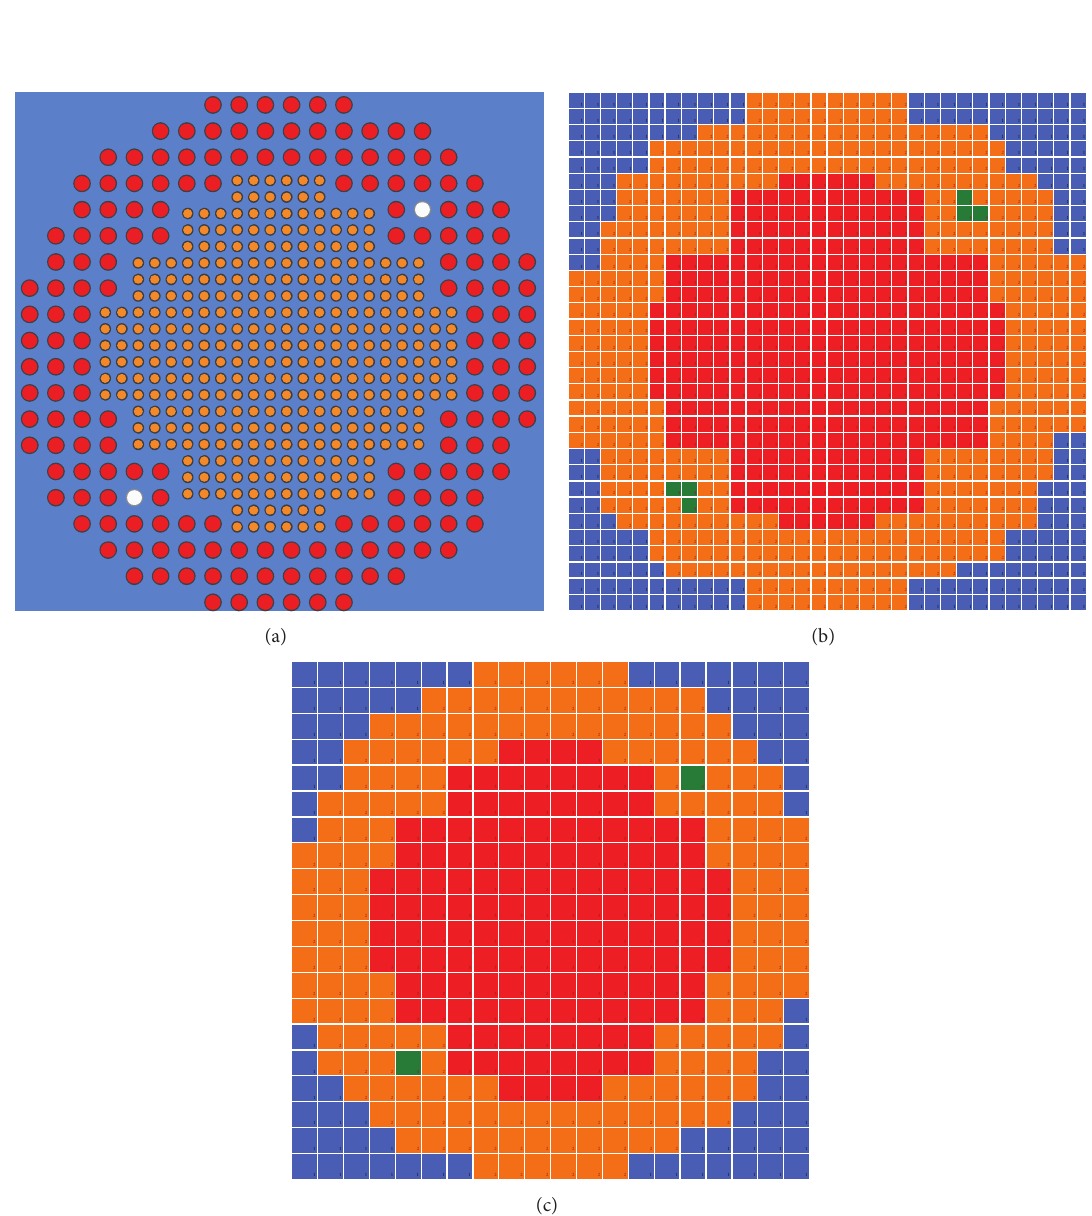
Figure 9: (a) Serpent 2 full-core model. (b) PARCS UO 2 cell-size mesh model. (c) PARCS U-metal cell-size mesh